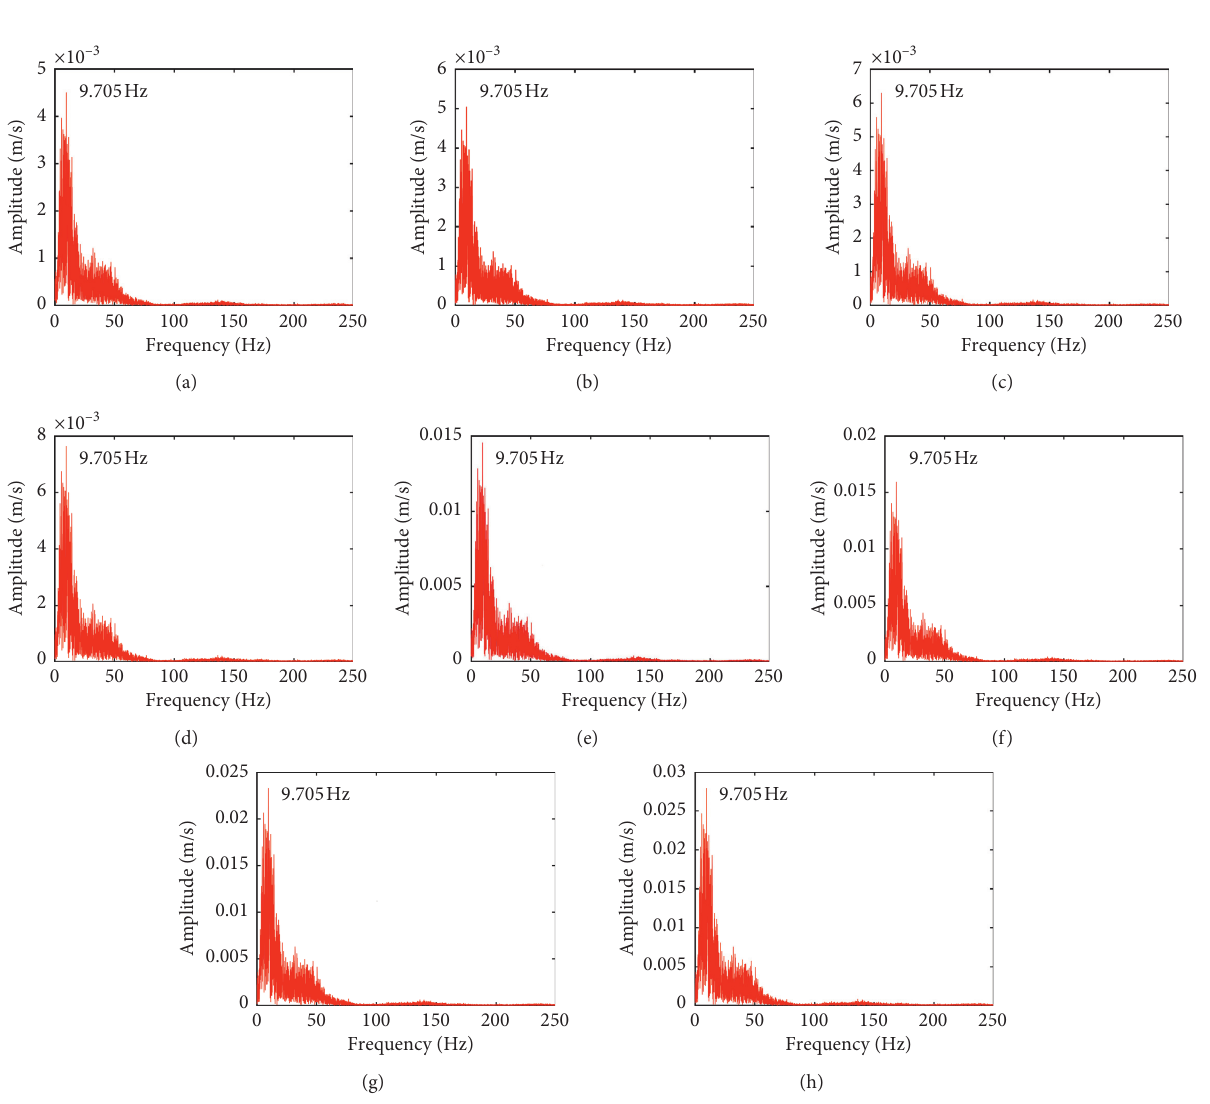
Figure 14: The spectral map of the velocity of each monitor block. (a) Block A1. (b) Block A2. (c) Block A3. (d) Block A4. (e) Block B1. (f) Block B2. (g) Block B3. (h) Block B4. Table 4: The energy proportion of frequency band of each monitoring block in Model 1. Rock